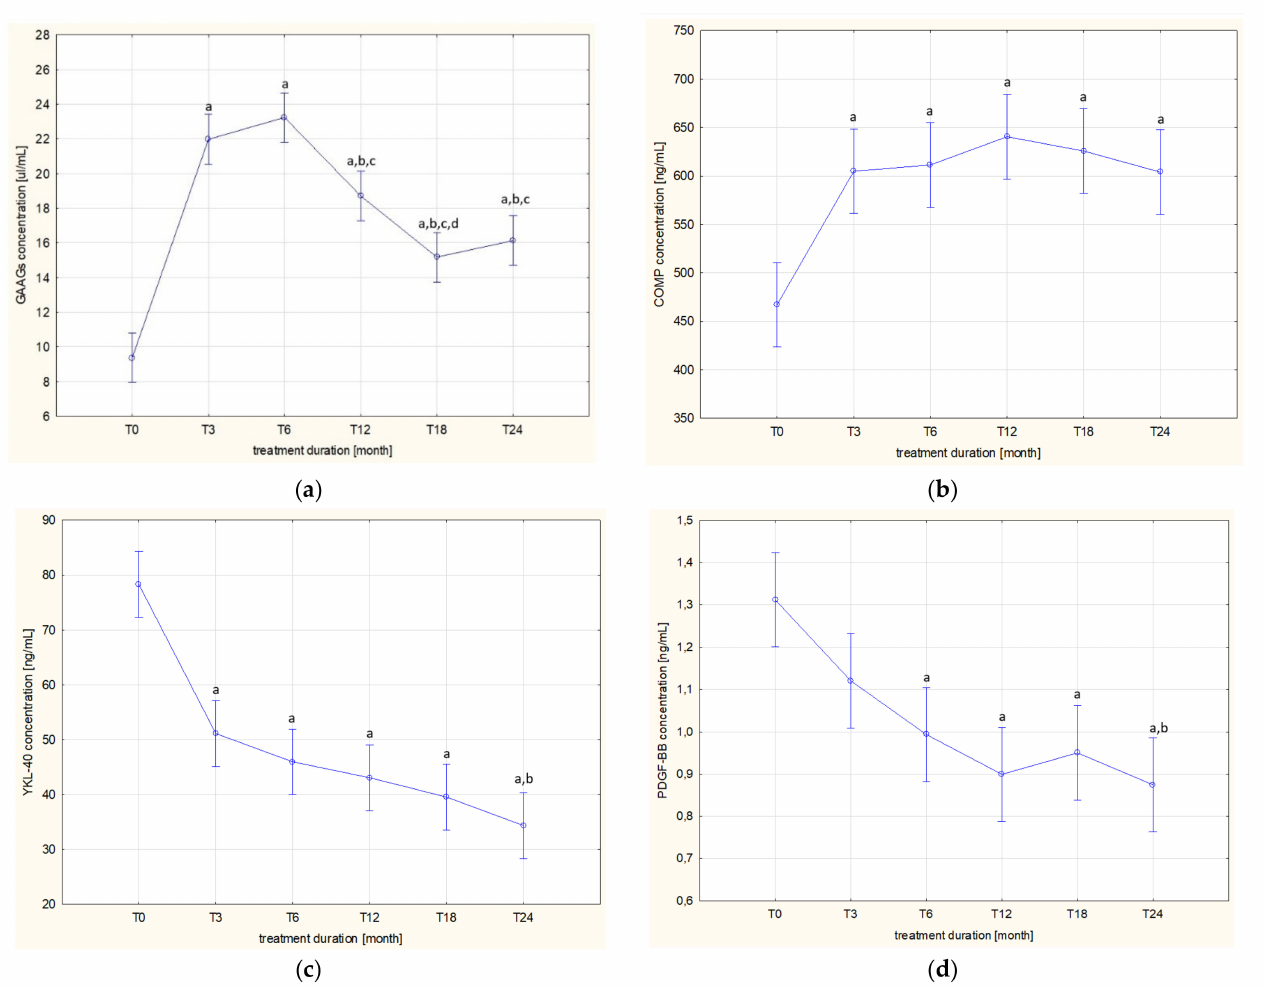
Figure 1. Dynamics of changes in plasma levels of GAAGs ( a ), COMP ( b ), YKL-40 ( c ), and PDGF-BB ( d ) in patients with JIA before and during etanercept therapy; a p < 0.05 compared to T0 group; b p < 0.05 compared to T3 group; c p < 0.05 compared to T6 group; d p < 0.05 compared to T12